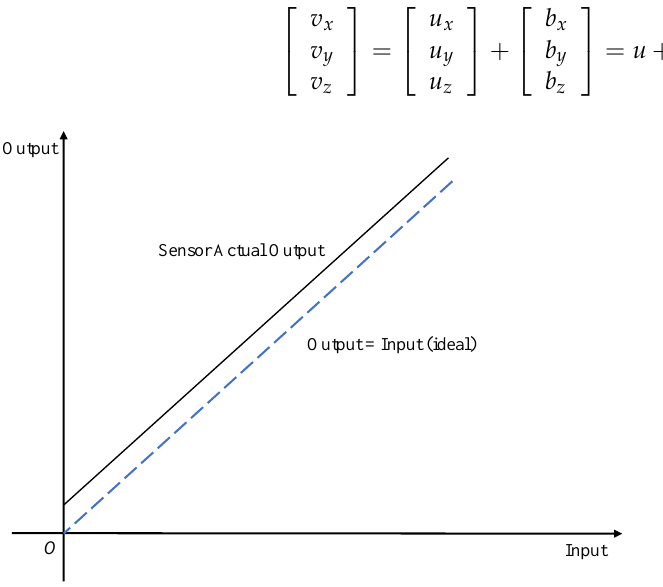
Figure 3. Zero-bias error